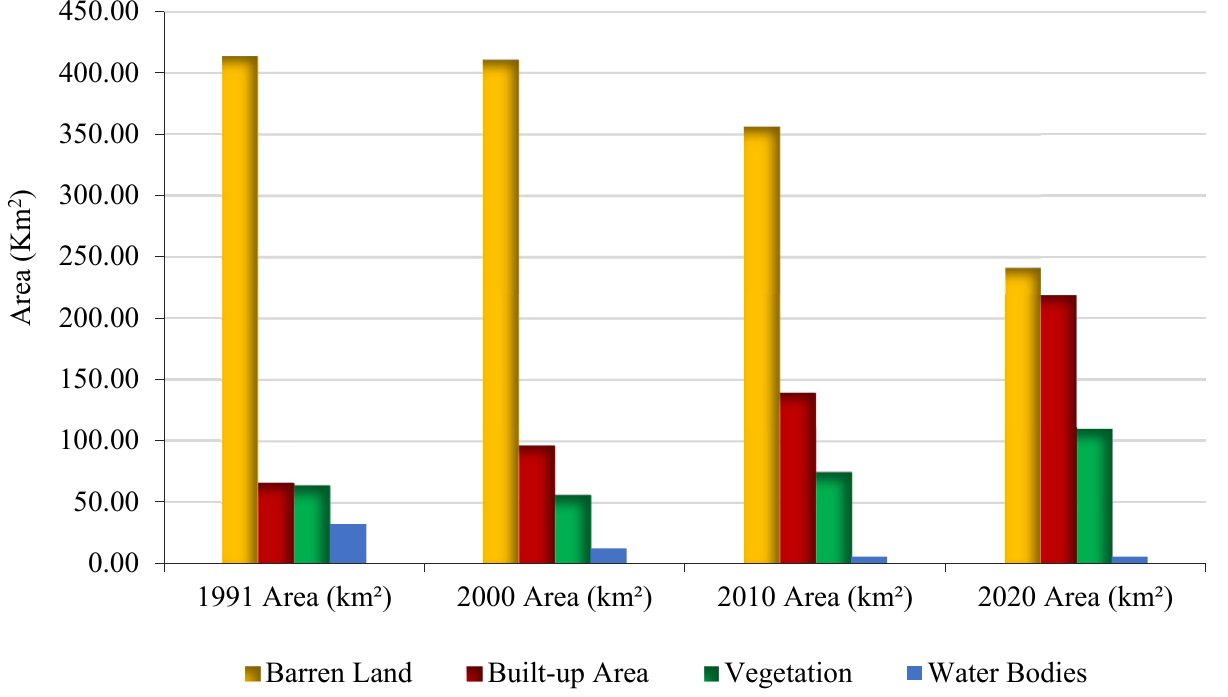
Figure 3. Classified LULC of the study area, i.e., Kano metropolis in 1991, 2000, 2010, and 2020.